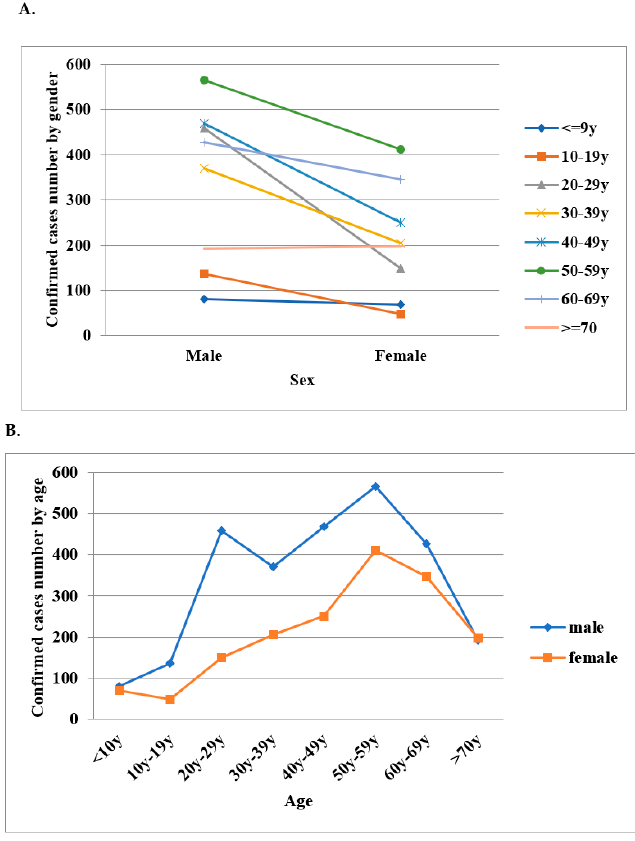
Figure 2. ( A ). Sex distribution dominated by age groups for domestic and imported patients with scrub typhus between 2010 and 2019. ( B ). Age distribution dominated by men and women for domestic and imported cases of scrub typhus between 2010 and 2019.